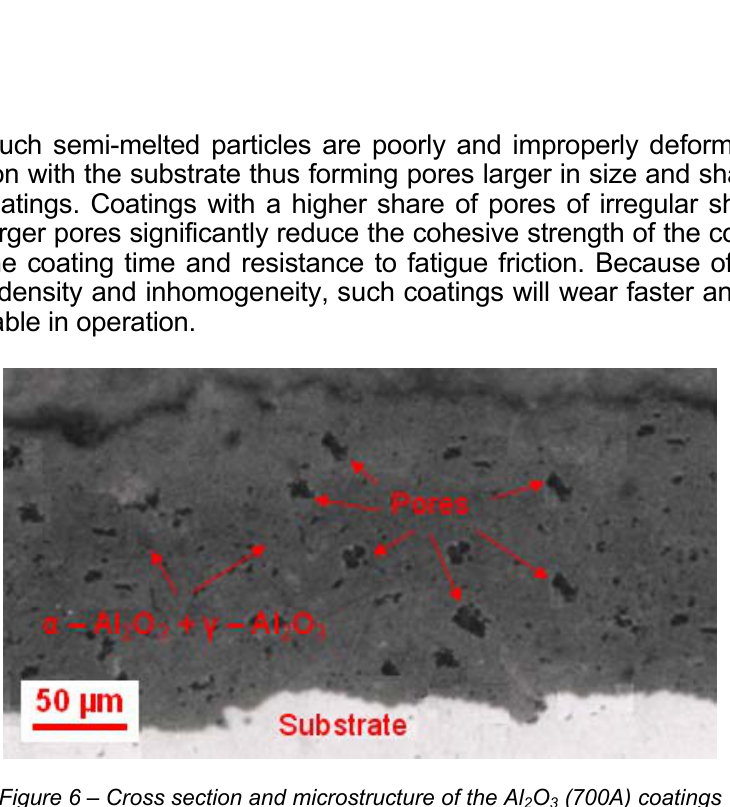
Figure 6 – Cross section and microstructure of the Al 2 O 3 (700A) coatings Рис . 6 – Поперечное сечение и микроструктура Al 2 O 3 покрытия (700A) Слика 6 – Попречни пресек и микроструктура Al 2 O 3 превлаке (700